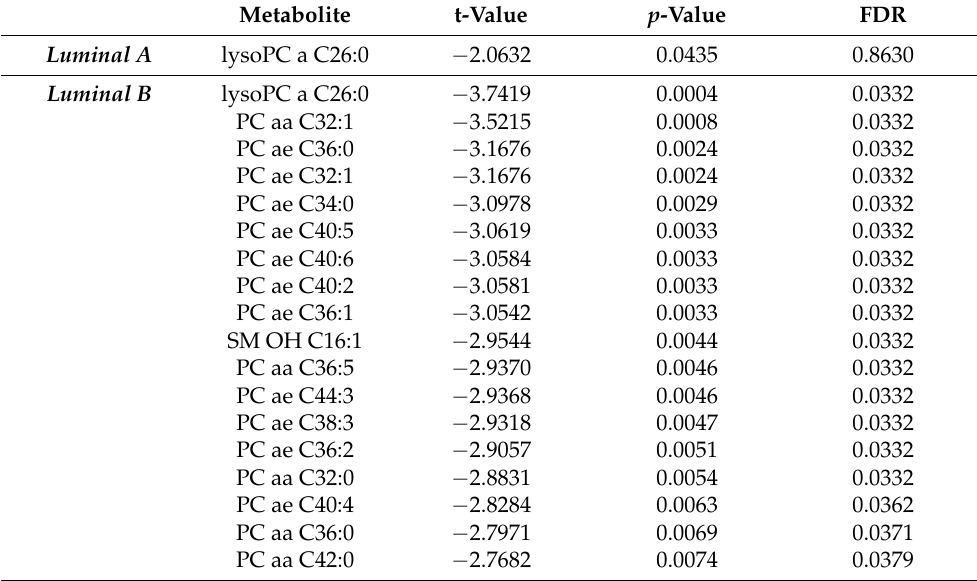
Table A3. Differentially expressed metabolites, comparing molecular subtypes to healthy controls. Due to the abundance of significant metabolites for luminal B only those with an FDR ≤ 0.05 are shown